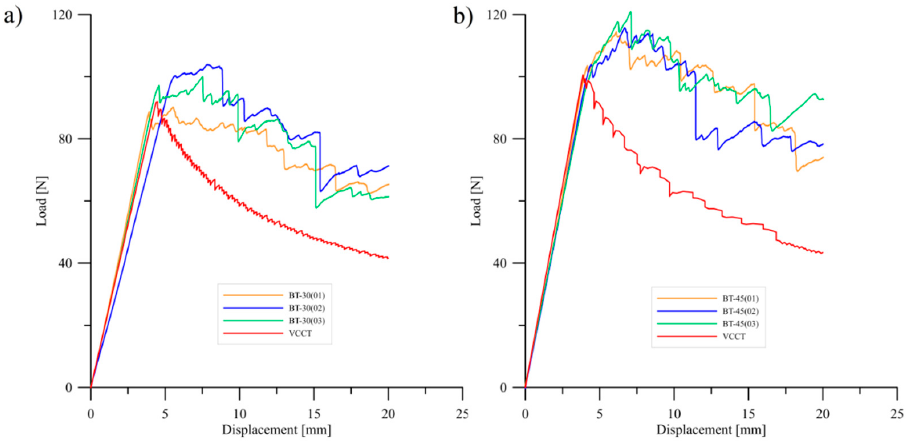
Figure 7. Experimental and numerical load versus displacement plots obtained for: ( a ) the BT30 and ( b ) the BT45 bending–twisting laminates.